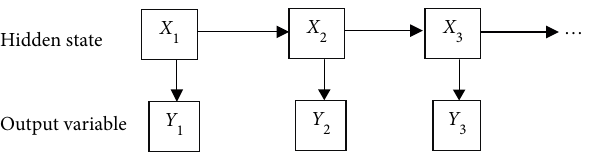
Figure 1: Bayesian network representation of HMM.